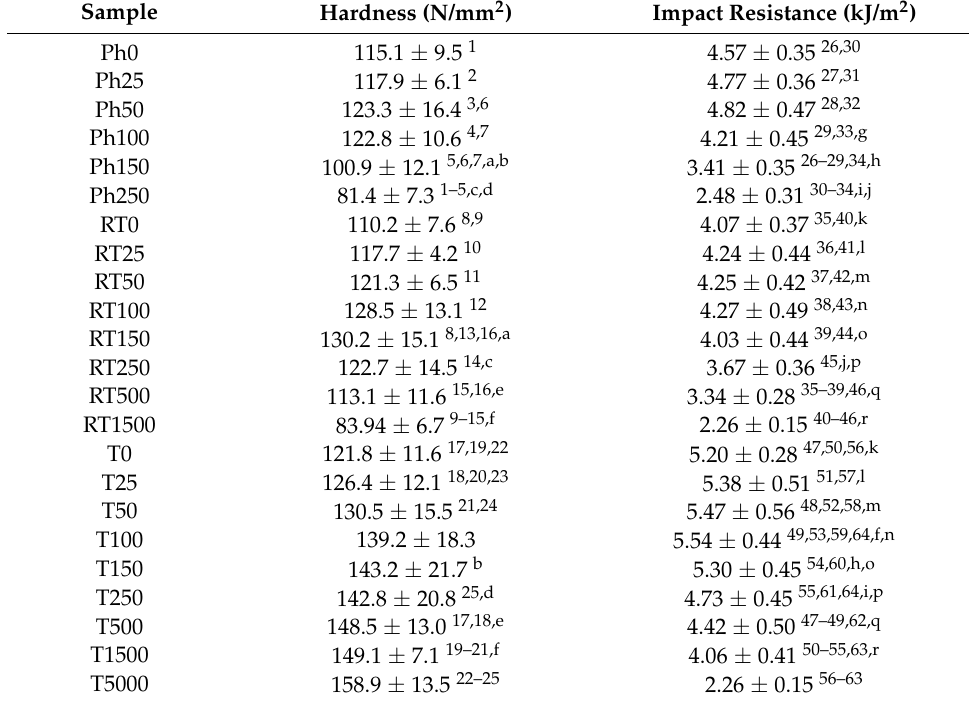
Table 5. Hardness and impact resistance of studied Bis-GMA/TEGDMA/AgNP